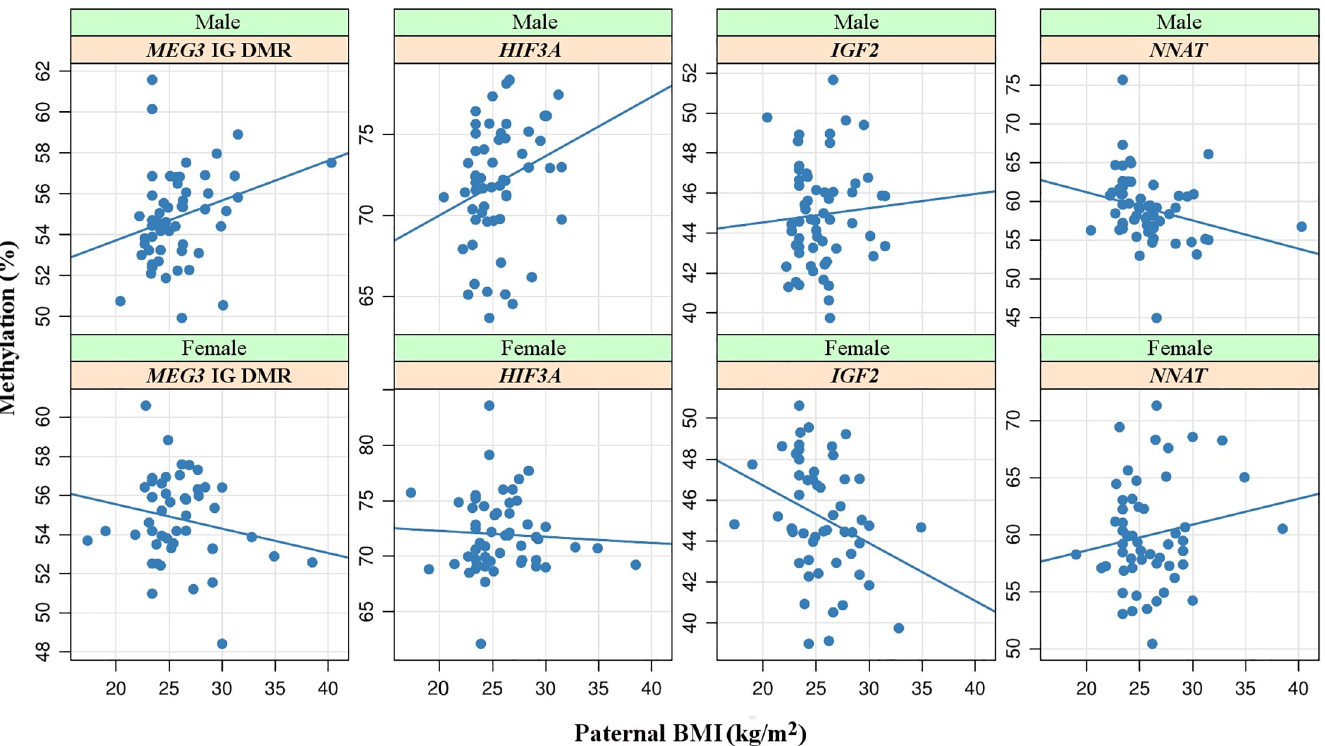
Fig 1. Correlation of paternal BMI with cord blood DNA methylation. Scatter plots showing the correlation between MEG3 -IG DMR, HIF3A , IGF2 , and NNAT methylation and the paternal BMI in male fetal cord blood (upper panel) and female fetal cord blood (lower panel) samples. Each dot in the plot represents the average methylation of several targeted CpGs in an individual cord blood sample after measurement by bisulphite pyrosequencing. Regression line suggests direction of correlation with paternal BMI. RE on each plot indicates the regression estimate.